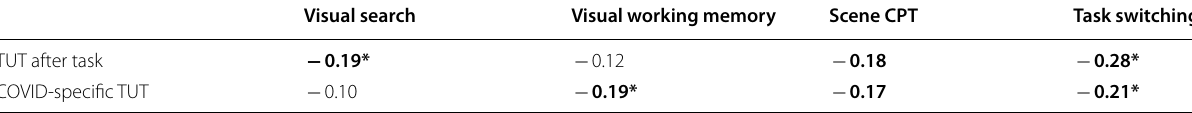
Bold indicates uncorrected p < 0.01